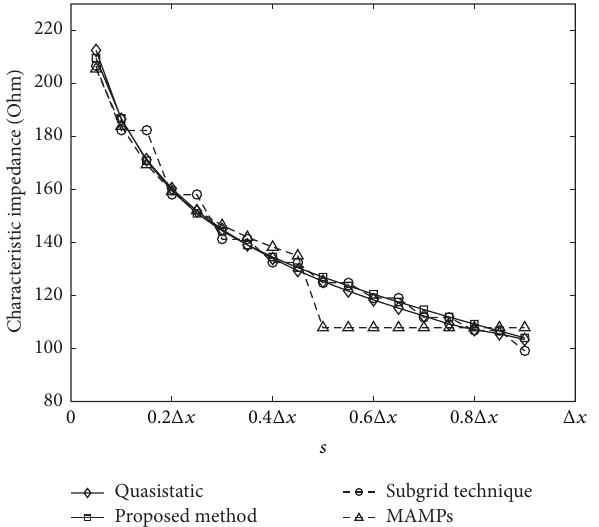
Figure 5: Calculated results of the proposed method with different grid